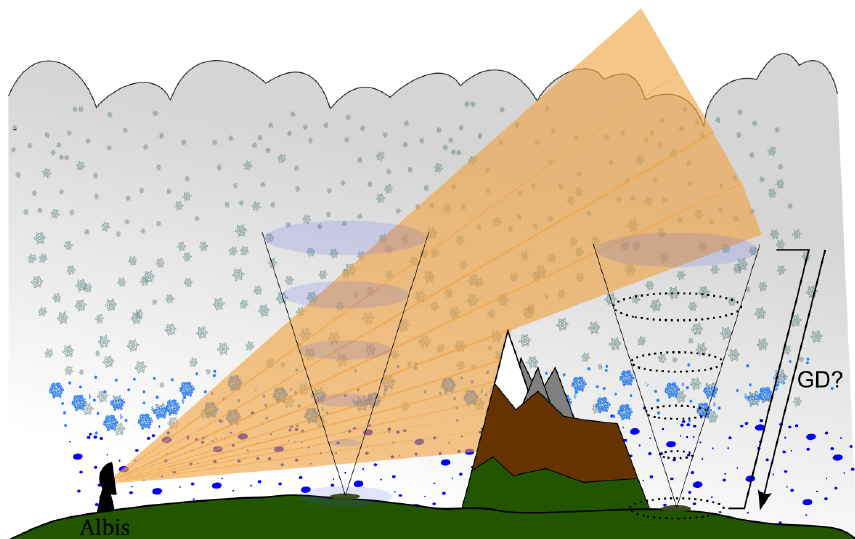
Figure 2. Cones are extracted in well-visible regions of the radar and used to train the ANN. The trained ANN model can then be used to extrapolate measurements from aloft to the ground level during other precipitation events or in regions with reduced